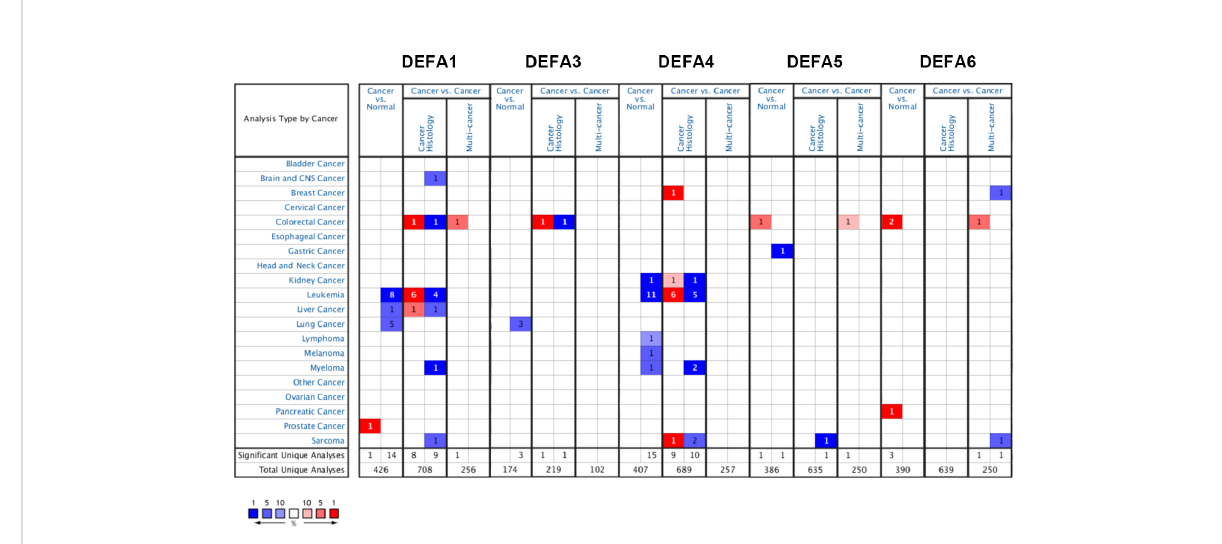
FIGURE 2 The transcription levels of DEFA factors in different types of cancers